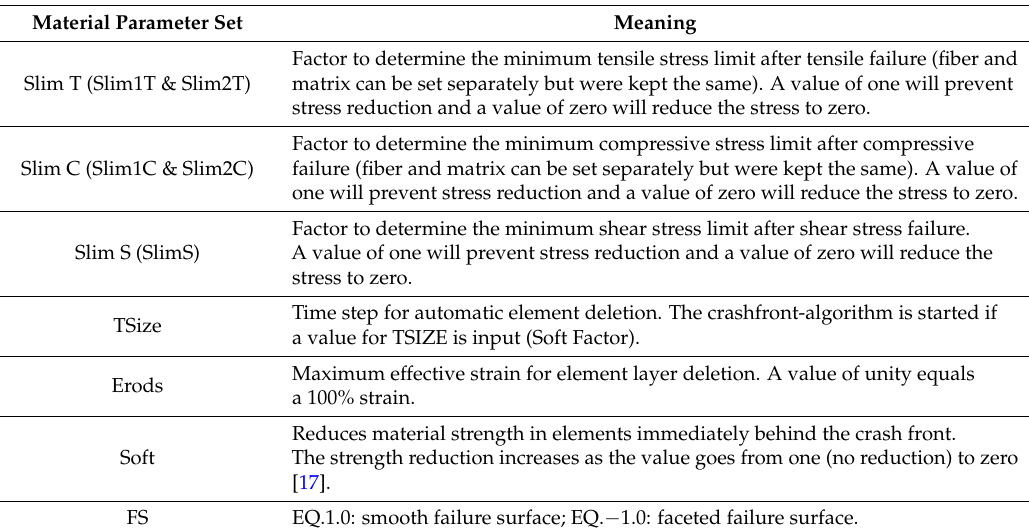
Table 3. Additional material parameters set within the model